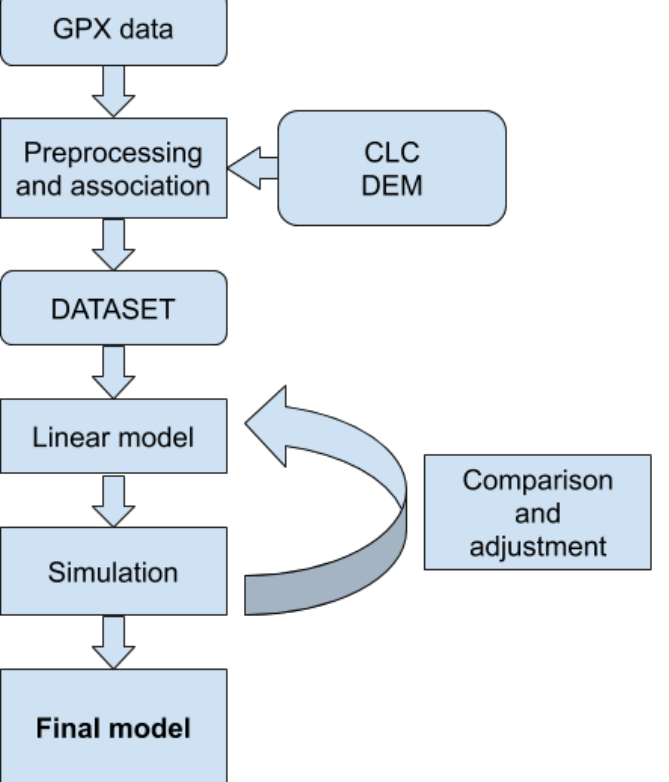
Figure 4. The process of building the